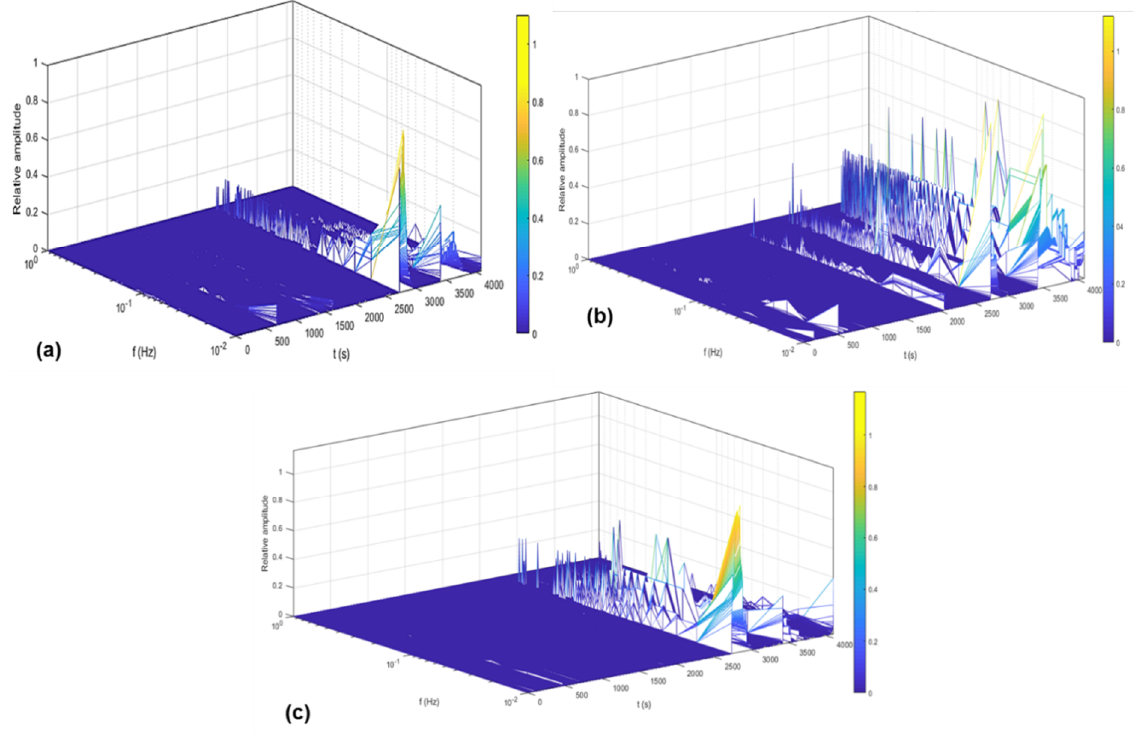
Figure 7. The Hilbert spectra of Ti-alloys for ECN data in 3.5 wt. % H 2 SO 4 solution. ( a ) Ti CP2 ( b ) Ti-6Al-2Sn-4Zr-2Mo ( c ) Ti-6Al-4V.